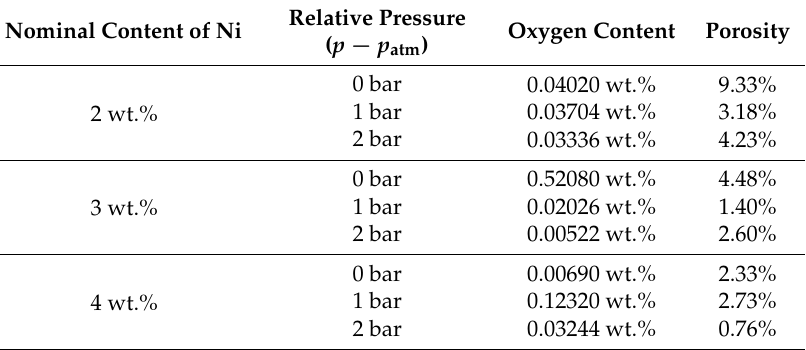
Table 2. Oxygen content in the fabricated samples determined using a LECO analyzer and porosities determined using metallographic analysis.